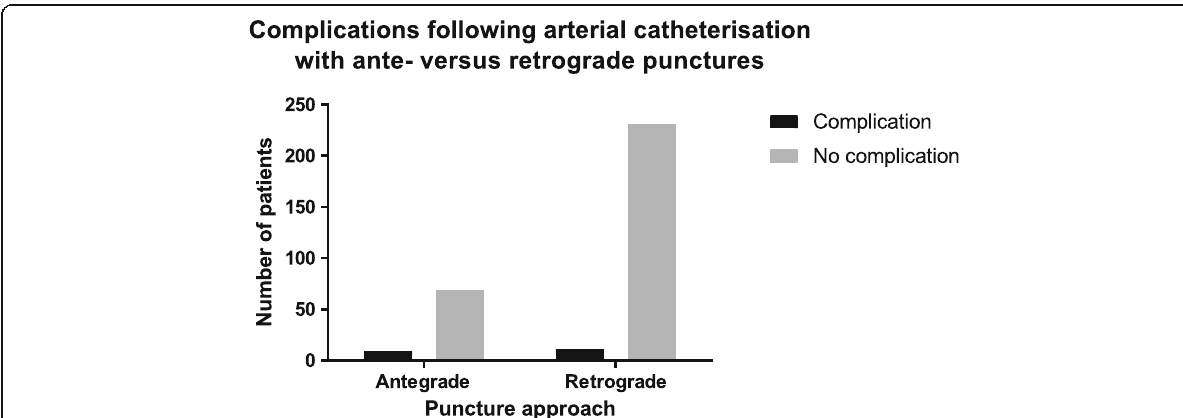
Fig. 2 Bar-chart demonstrating lower complication rates following retrograde arterial catheterisation compared with the antegrade approach. Legend: Complications following arterial catheterisation with ante-versus retrograde